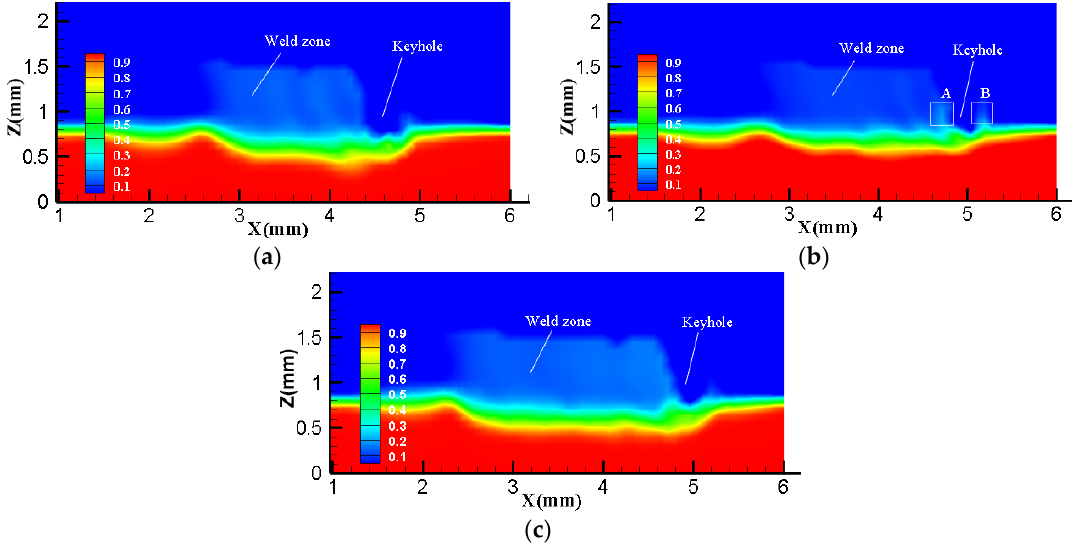
Figure 5. Longitudinal section views of the calculated concentration profile of Ti for different process parameters: ( a ) laser power 500 W, and welding velocity 3.2 m/min; ( b ) laser power 500 W, and welding velocity 3.6 m/min; ( c ) laser power 520 W, and welding velocity 3.6 m/min.